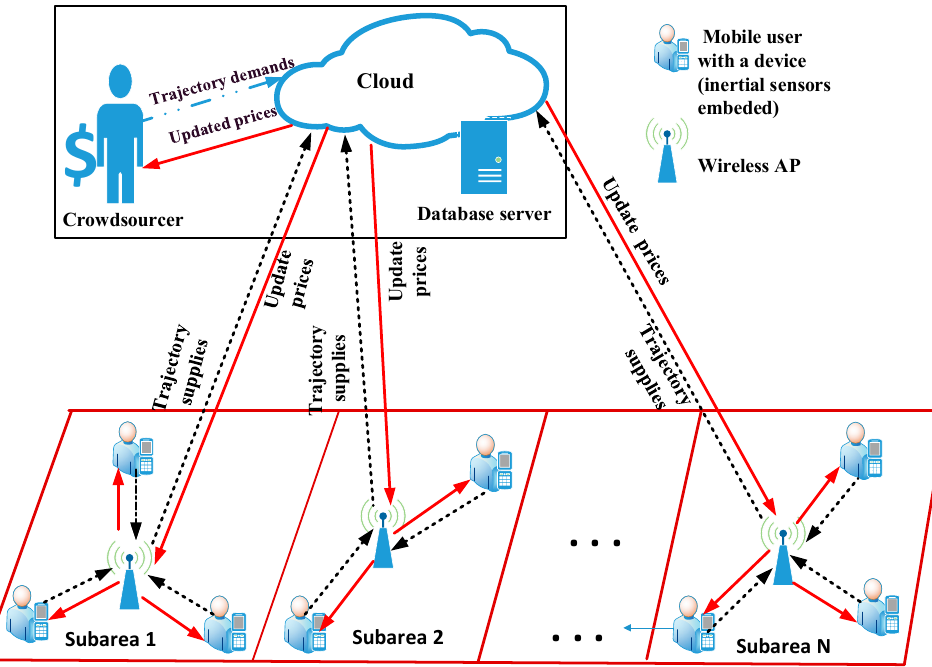
Figure 1. Mobile crowdsourcing model for indoor fingerprint localization.